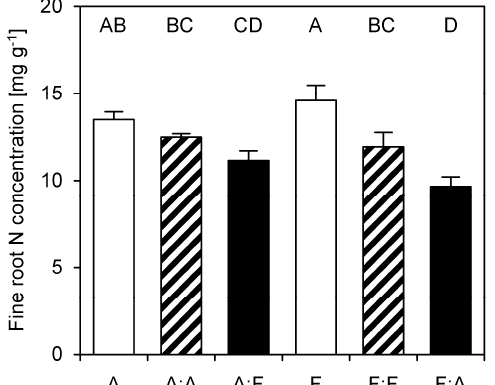
Figure 7. Fine root nitrogen (N) concentration of Acer pseudoplatanus (A) and Fagus sylvatica (F) grown under three different competition treatments into nutrient-rich soil patches. A, Acer root grown in isolation (no competition); A:A, Acer root grown in competition with another Acer root; A:F, Acer grown in competition with Fagus ; F, Fagus grown in isolation; F:F, Fagus grown in competition with Fagus ; F:A, Fagus grown in competition with Acer . Significant differences between treatments are indicated by different letters ( t -test, p < 0.05, mean + SE, n = 4–5; see Supplementary Table S10 for GLM statistics).